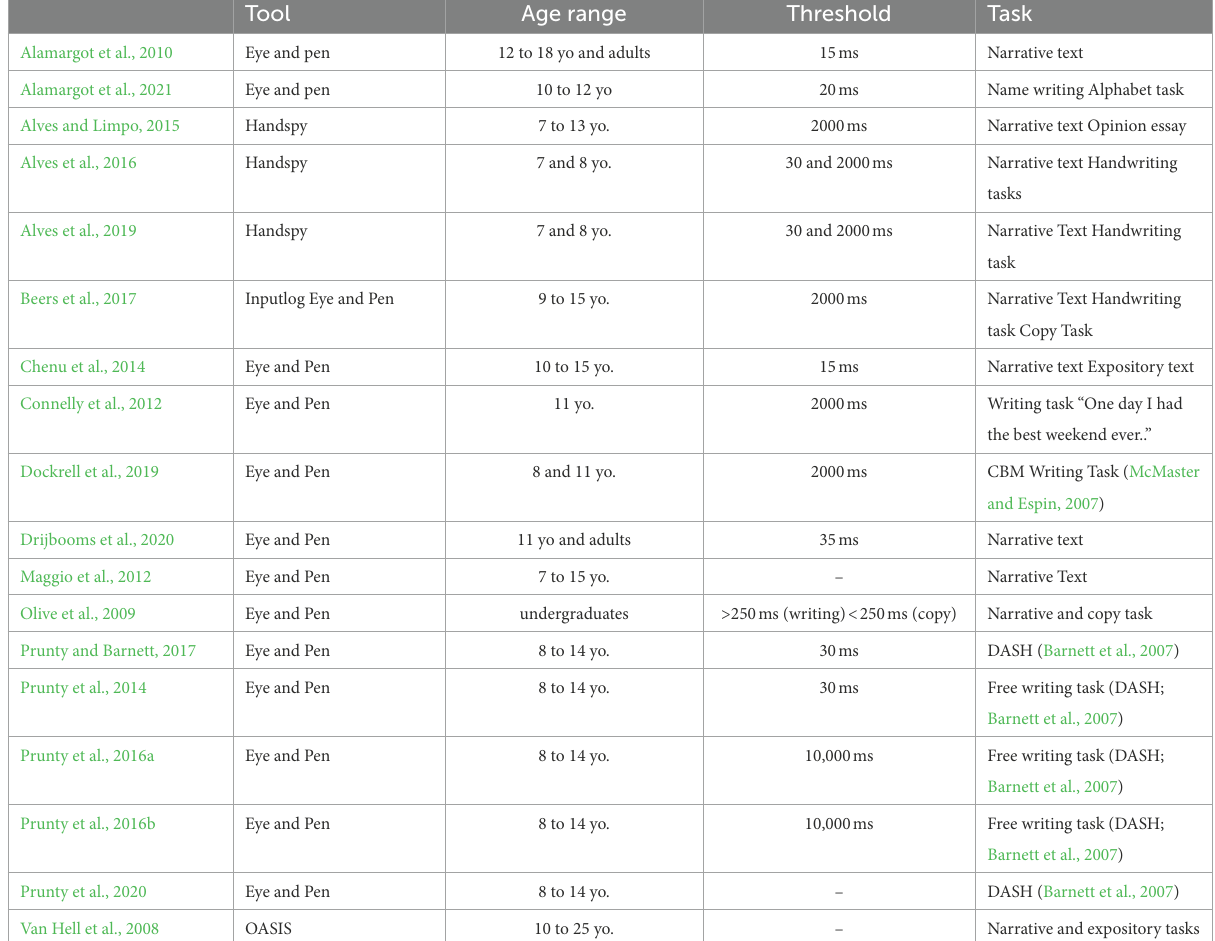
TABLE 1 Summary of tools, thresholds and tasks in a selection of previous